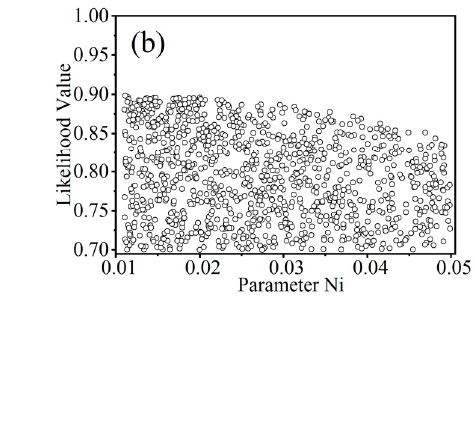
9 of 18 Table 3. Three sampling methods: SA screening sensitive parameters and a combined relatively sensitive parameter. Group